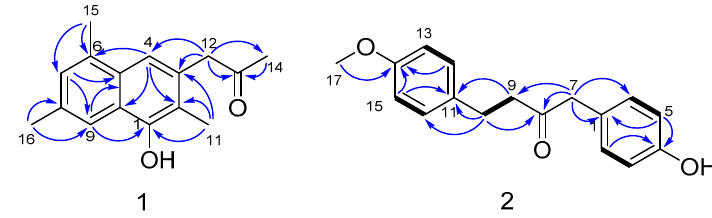
Figure 2. 1 H- 1 H COSY (bold line) and the key HMBC (blue arrow) correlations of compounds 1 and 2 . Compounds 3 – 6 were identified as dichotocejpin C [12], bis- N -norgliovictin [10], bassiatin [13] and (3 R , 6 R )-bassiatin [14], respectively, by comparing the data with the literature values. The (3 R , 6 R )-bassiatin ( 6 ) and bassiatin ( 5 ) are a pair of diastereomers. In the previous research,